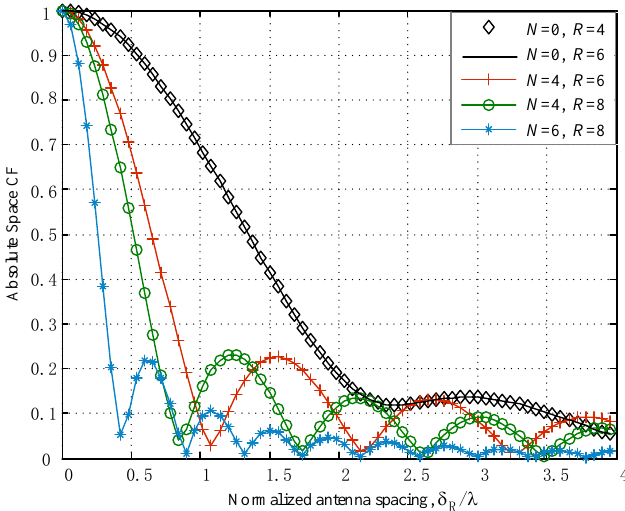
Figure 2. Proposed time-variant space CFs for the LoS and NLoS paths, with respect to the reflection number N and the radius of the tunnel R